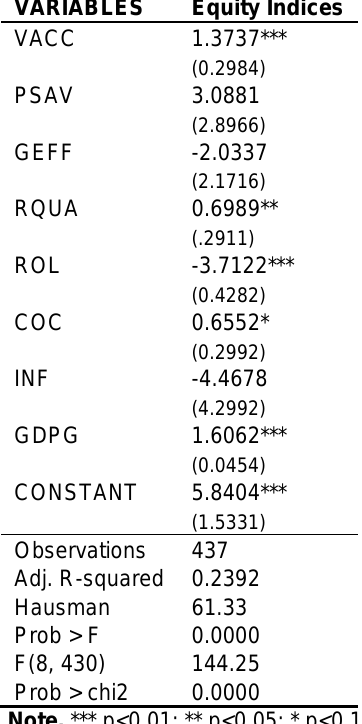
Table 7. Regression results from fixed effects